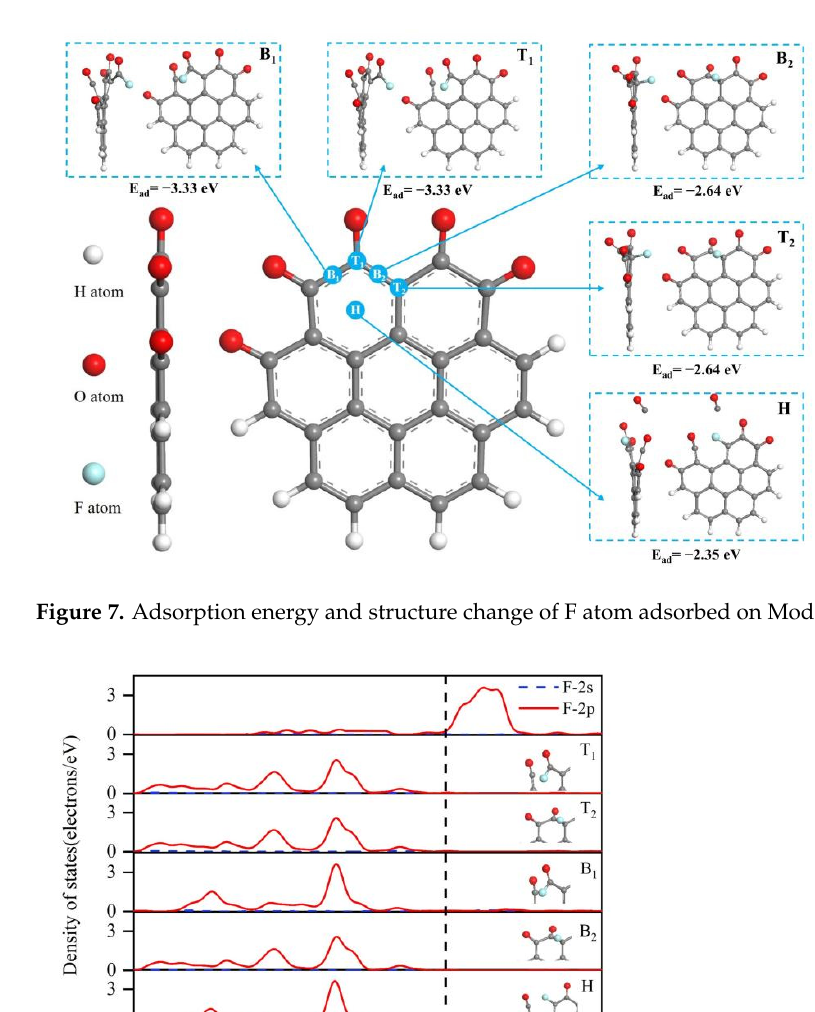
( b ) Figure 9. Total density of states and the projected density of states of O, C and F atoms: ( a ) ad- sorbed at B 1 site; ( b ) adsorbed at T 2 site. Through adsorption energy and density of state calculation analysis, it is known that the preferential discharge sites of the F atom on the carbon anode are B 1 (the same as T 1 ) and T 2 (the same as B 2 ). The transition of the anode structure was then analyzed when fluorine atom continues to adsorb. The sites after adsorption at B 1 and T 2 were taken as the